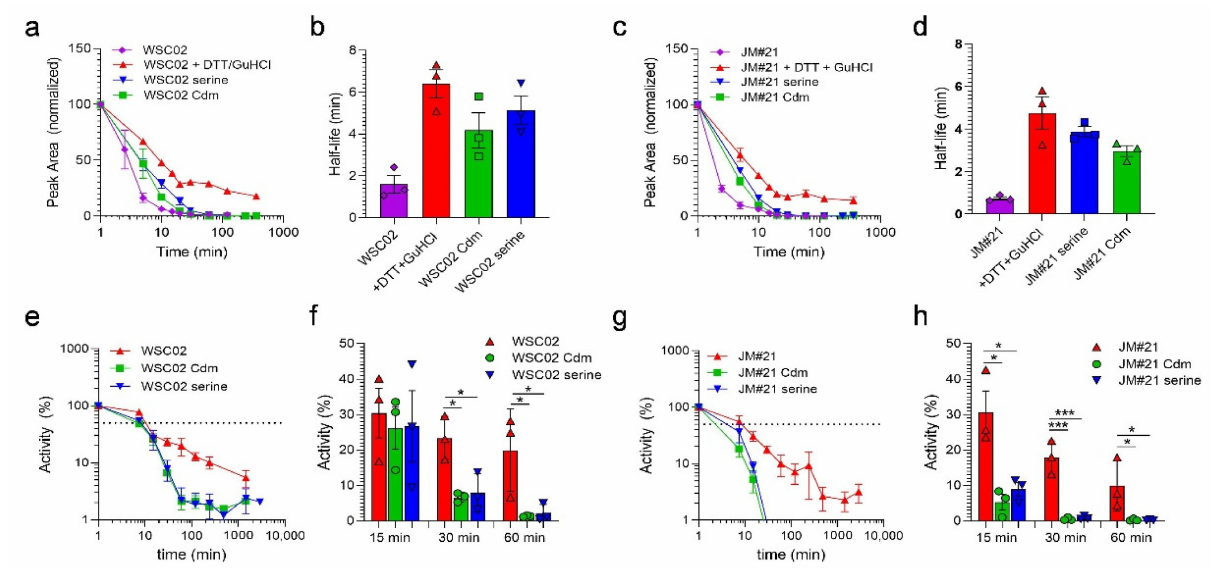
Figure 5. Cysteine residues in EPI-X4 WSC02 and JM#21 increase their stability in plasma: ( a – d ) Half- lives of WSC02, JM#21, and modified variants detected by mass spectrometry, ( a , c ) intact peptide normalized to t = 0 min; ( b , d ) half-life values determined by one-phase decay. ( e – h ) Stability of peptides analyzed by a functional stability assay. ( e , g ) Peptides were spiked into human plasma and incubated at 37 ◦ C. Remaining activity was determined by antibody competition assay. ( f , h ) Re- maining activity after 15 min, 30 min, and 60 min. Shown are data derived from 3 individual rounds of plasma incubation ± SEM. * p < 0.05, *** p < 0.0001 (one-way ANOVA, Tukey’s multiple comparison